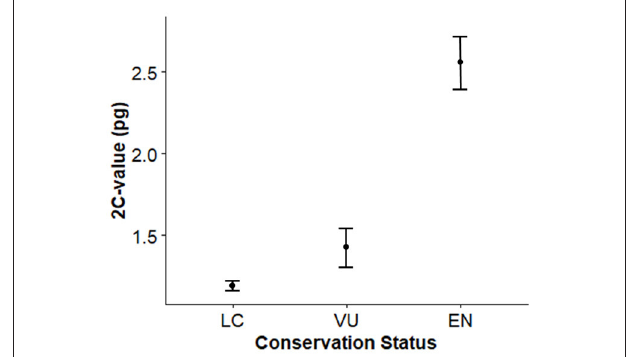
FIGURE 7 | Differences in genome size among Aeonium species of different conservation status. LC, Least Concern; VU, Vulnerable; EN,